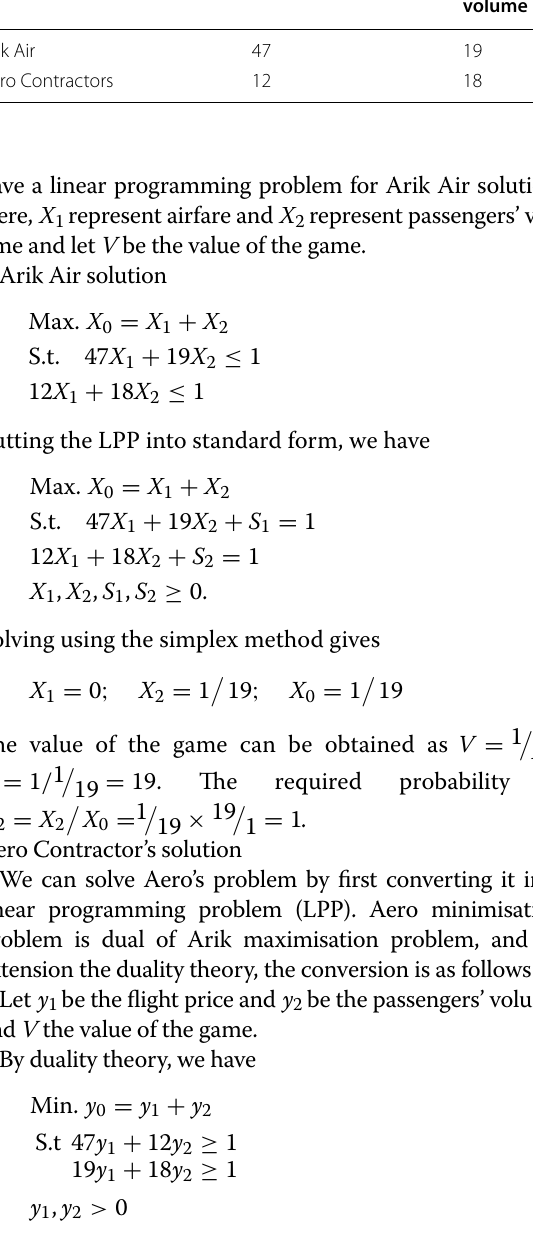
Table 1 Airfare and passengers’ strength of Arik Air and Aero Contractors. Source: Researchers (2019)